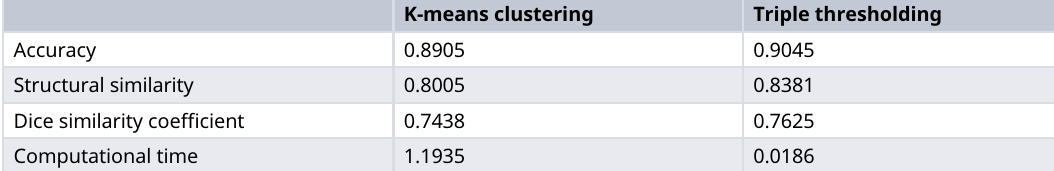
Table 1. Comparison between previous work (K-means clustering) and proposed work (Triple